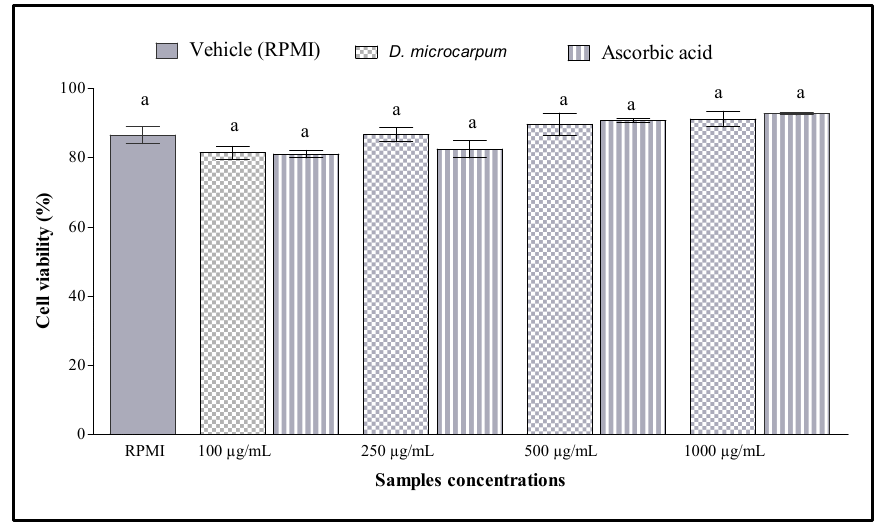
Figure 1. Cytotoxic effect of ethanol extract and ascorbic acid. a Values with the same superscripted letters do not differ significantly ( p > 0.05) as determined by analysis of variance. Antioxidants 2018 , 7 , x FOR PEER REVIEW 7 of 10